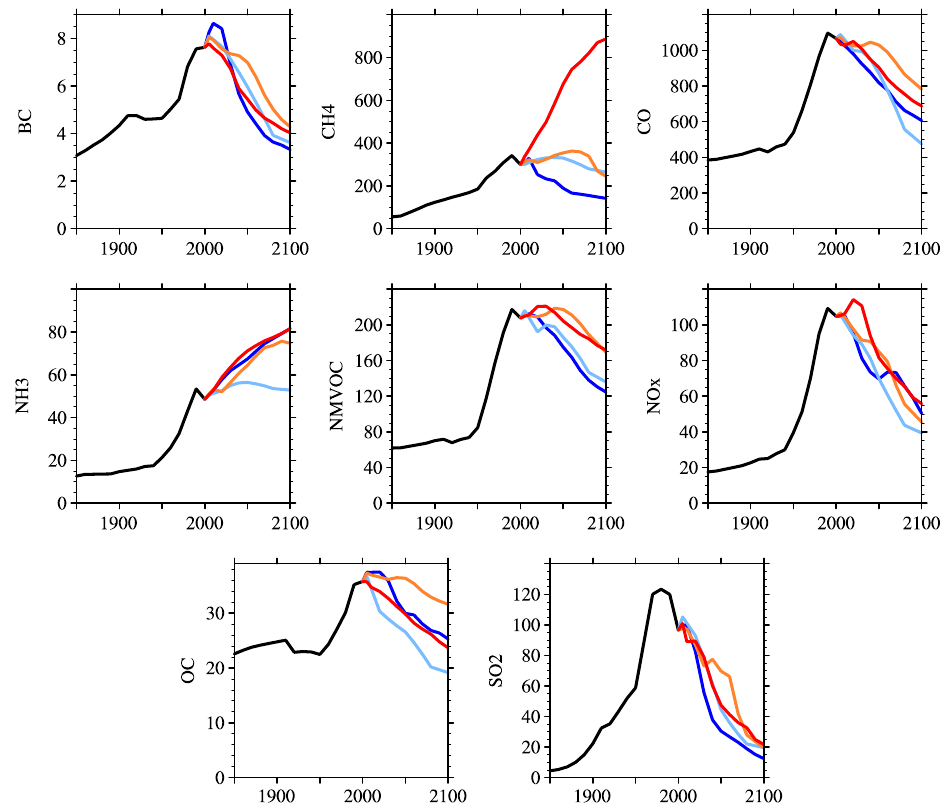
Fig. 1. Time evolution of global anthropogenic+biomass burning emissions 1850–2100 following each RCP; blue (RCP2.6), light blue (RCP4.5), orange (RCP6.0) and red (RCP8.5). BC represents black carbon (in Tg ( C ) yr − 1 ), OC organic carbon (in Tg ( C ) yr − 1 ), NMVOC non-methane volatile organic compounds (in Tg ( C ) yr − 1 ) and NO x nitrogen oxides (in Tg ( NO 2 ) yr − 1 ). Other panels are in Tg ( species ) yr − 1 . Historical (1850–2000) values are from Lamarque et al. (2010). RCP values are from van Vuuren et al. (2011) and references